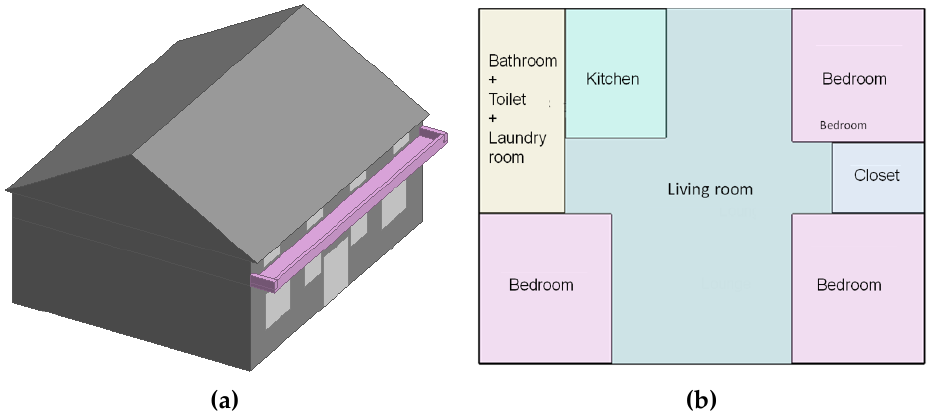
Figure 6. Typical rural house model: ( a ) 3D model; and ( b ) Configuration.